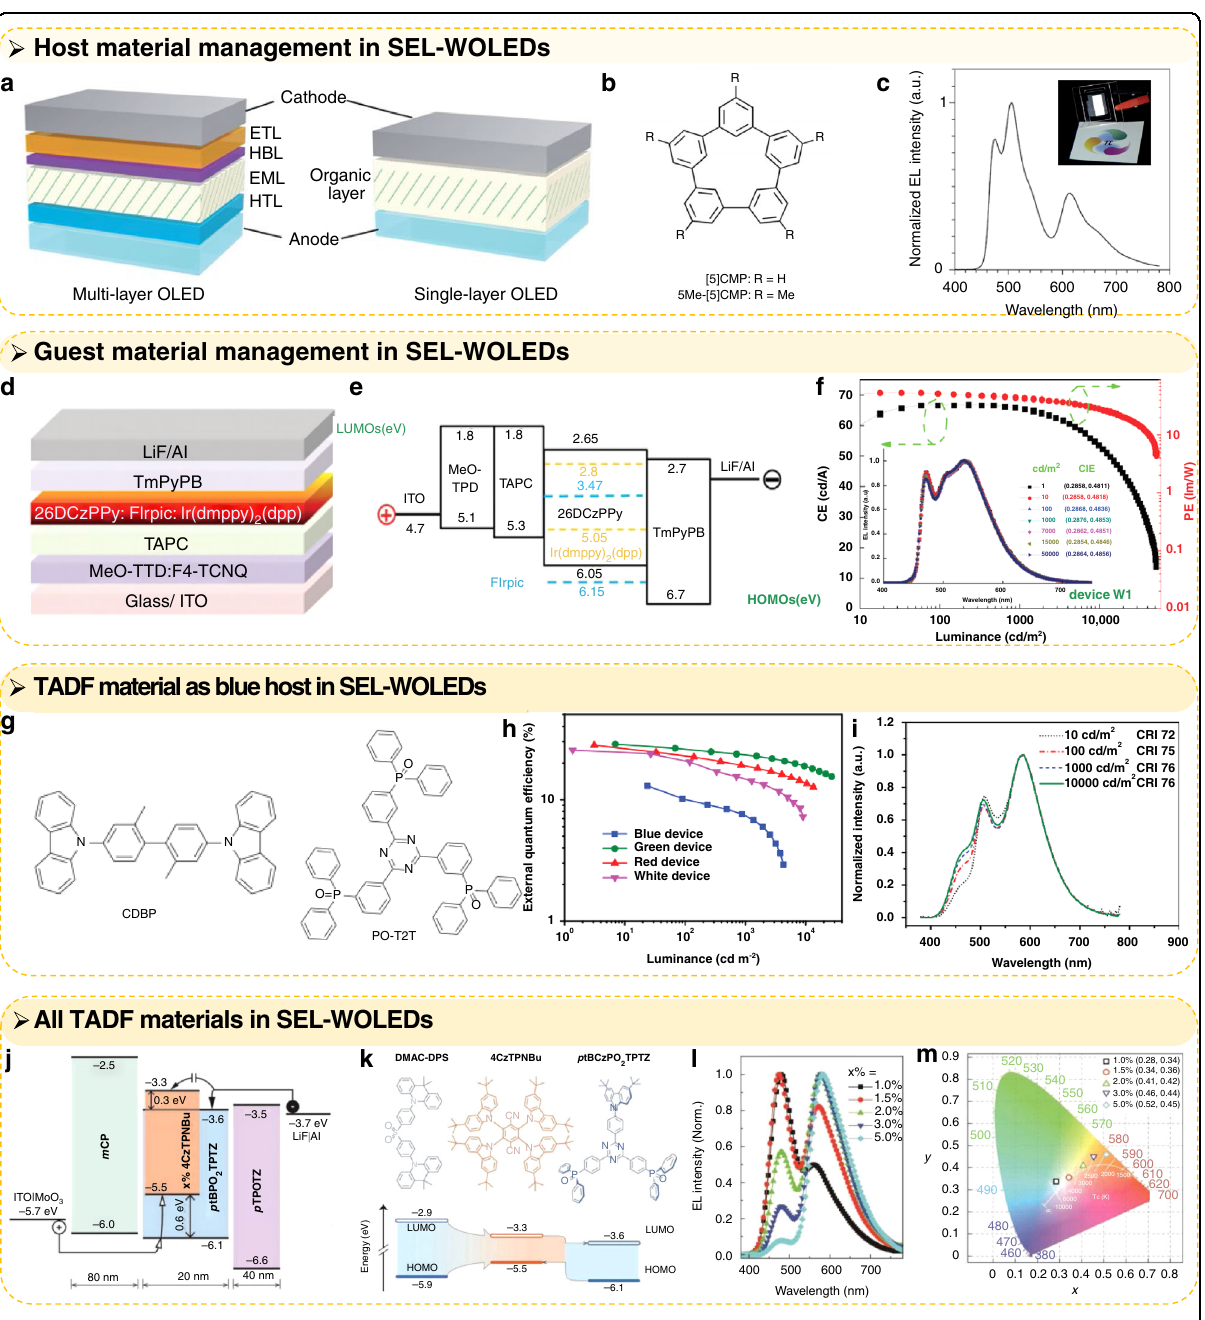
Fig. 5 Management of carrier transport and exciton recombination in SEL – WOLEDs. a Architectures of electrophosphorescent OLEDs: a multilayer OLED with a four-layer architecture and a single-layer OLED with a simple architecture. b Chemical structures of the CMPs (cyclo-meta-phenylenes). c Electroluminescence spectrum at a current density of 0.1mA cm 2 ; inset: a picture of the device with an emitting area of 16.6mm*6mm. Reprinted with permission from ref. 47 . Copyright 2016, The Royal Society of Chemistry. d The structure of SEL – WOLED (W1). e The proposed highest-occupied molecular orbital (HOMO) and lowest-unoccupied molecular orbital (LUMO) of the device. f Forward-viewing CE and PE as a function of luminance for device W1. Inset: normalised EL spectra along the whole range of luminance. Reprinted with permission from ref. 46 . Copyright 2015, The Royal Society of Chemistry. g Molecular structures of CDBP and PO-T2T. h EQE-luminance characteristics of the devices. i EL spectra and CRI values of the hybrid WOLED at different luminances. Reprinted with permission from ref. 20 . Copyright 2015, WILEY-VCH Verlag GmbH & Co. KGaA, Weinheim. j Device con fi guration of ITO/MoO 3 (6nm)/mCP (80nm)/blue TADF emitter:4CzTPNBu (x%, 20nm)/pTPOTPTZ (40nm)/LiF (1nm)/Al (100nm). k Chemical structures and frontier molecular orbital (FMO) energy- level scheme of blue-emitting ptBCzPO2TPTZ and DMAC-DPS and yellow-emitting 4CzTPNBu. l EL spectra of ptBCzPO2TPTZ-based devices with different x%. m CIE coordinate dependence of the devices on x% and the corresponding positions on the CIE 1931 chromaticity diagram. The black-body locus and the colour-temperature lines were added for reference. Reprinted with permission from ref. 41 . Copyright 2020, WILEY-VCH Verlag GmbH & Co. KGaA,